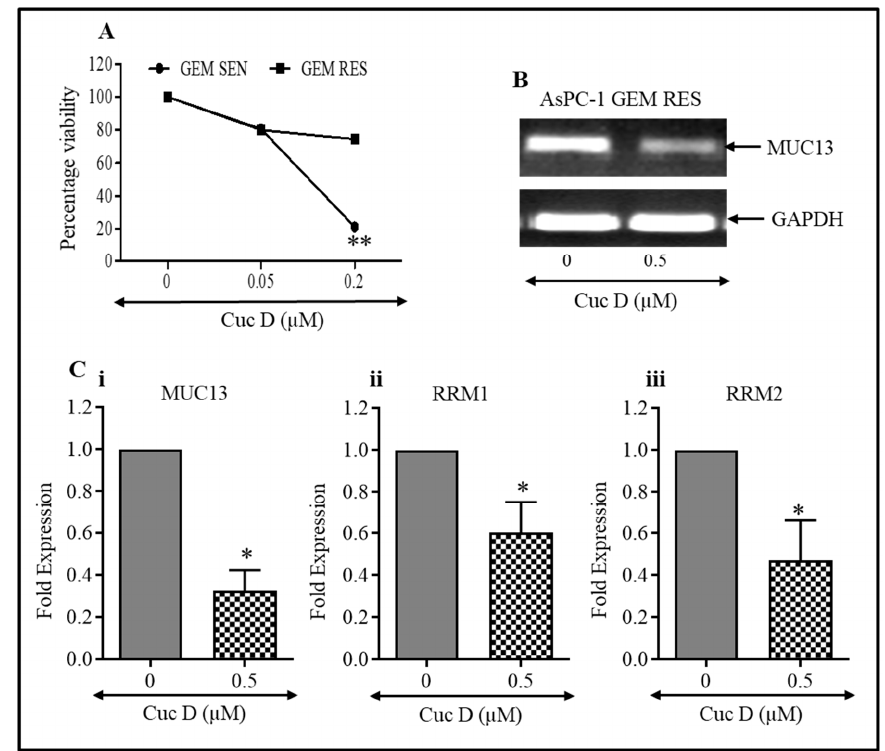
Figure 5. Effect of Cuc D on gemcitabine resistant AsPC-1 cells. ( A ) Briefly, 5000 cells were seeded in 96 well plate. Cells were treated with Cuc D at indicated concentrations for 48 h. Cell proliferation was determined by MTS assay. Line graph indicates the percent viability of PanCa cells with respect to vehicle control. Experiment was performed in triplicate. ( B ) Effect of Cuc D treatment on MUC13 expression in gemcitabine resistant AsPC-1 cells as analyzed by semi quantitative PCR. ( C ) Cuc D treatment decreases the mRNA expressions of MUC13 and drug resistant genes ( RRM1 and RRM2 ) as determined by qRT-PCR. GAPDH was used as an internal control ( Ci – iii ). Student’s t-test was performed to analyze significant difference. Asterisk (*) denotes the significant value p < 0.05, and two asterisks (**) indicates a significant level of p < 0.01.